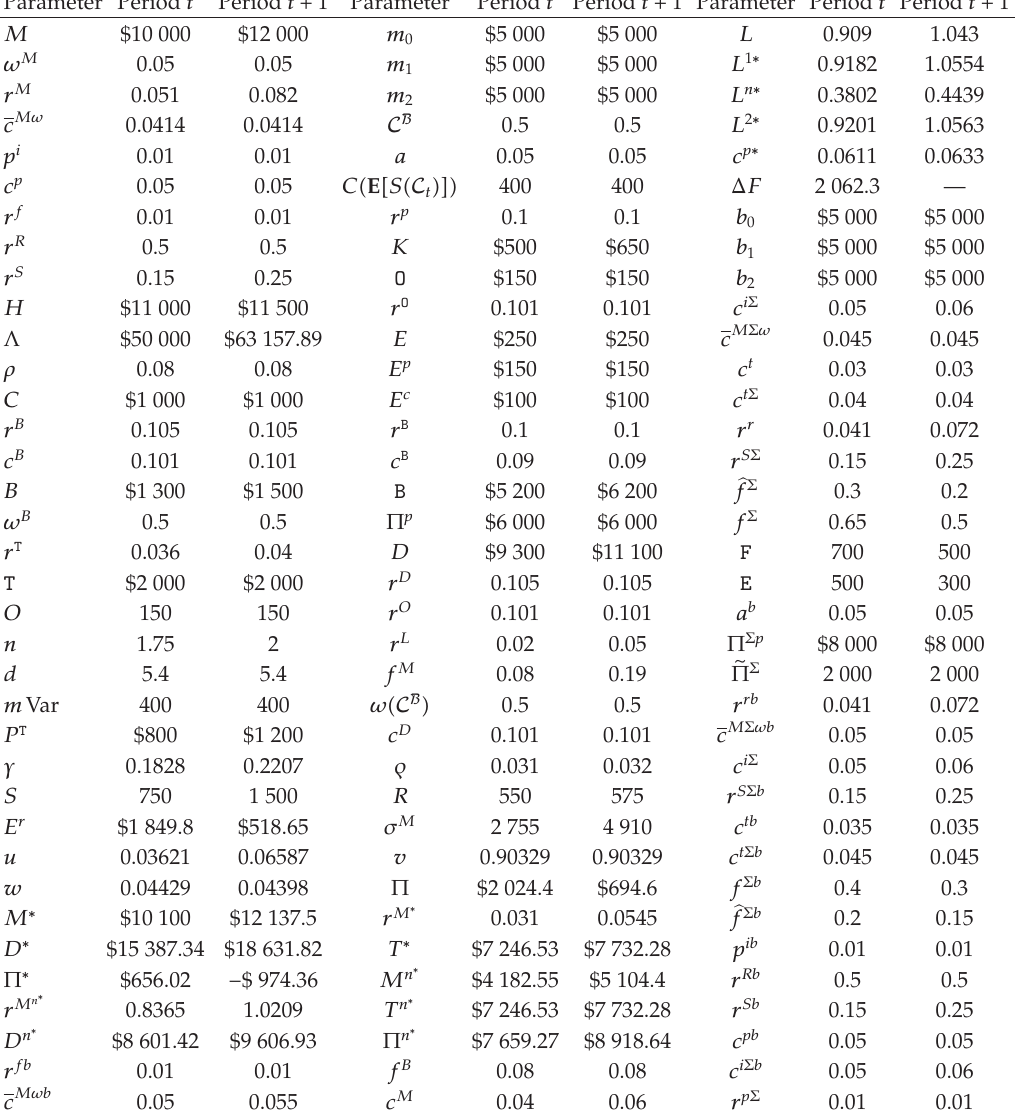
Table 4: Choices of subprime mortgage securitization